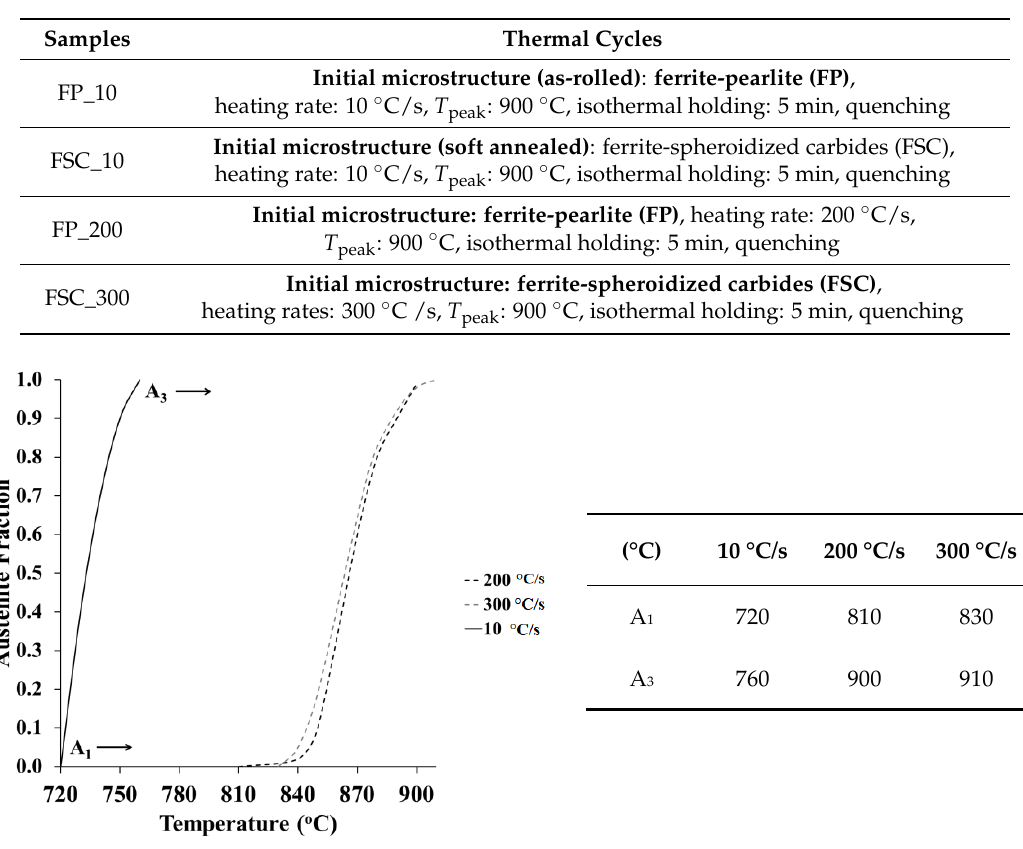
Figure 1. Diagram of austenite fraction in the α + γ region as derived from dilatometry curves for 10 ◦ C/s (equilibrium state), 200 ◦ C/s and 300 ◦ C/s heating rates. Temperatures A 1 and A 3 that were increased are closely related to heating rate increasing pattern.